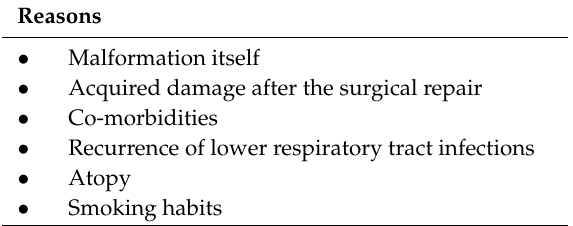
Table 3. Reasons for the persistence of respiratory morbidity in patients with repaired congenital esophageal atresia and tracheoesophageal